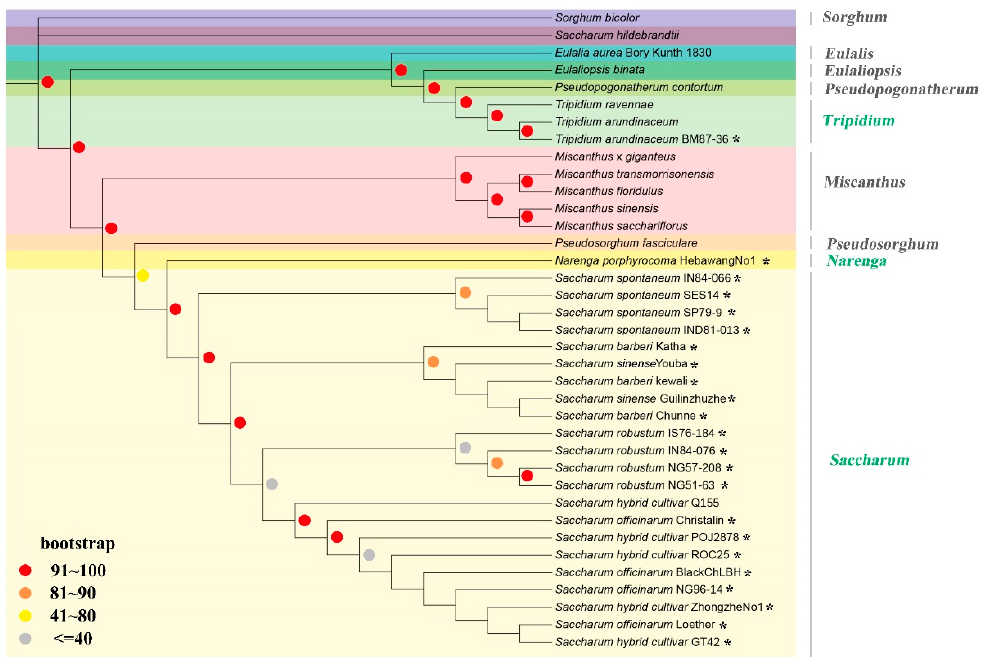
Figure 2. Phylogram based on 74 protein-coding genes shared among Saccharinae species (23 newly assembled in this study, which are marked with *, and 14 published accessions of Saccharinae species in NCBI). Sorghum bicolor is included as outgroup.